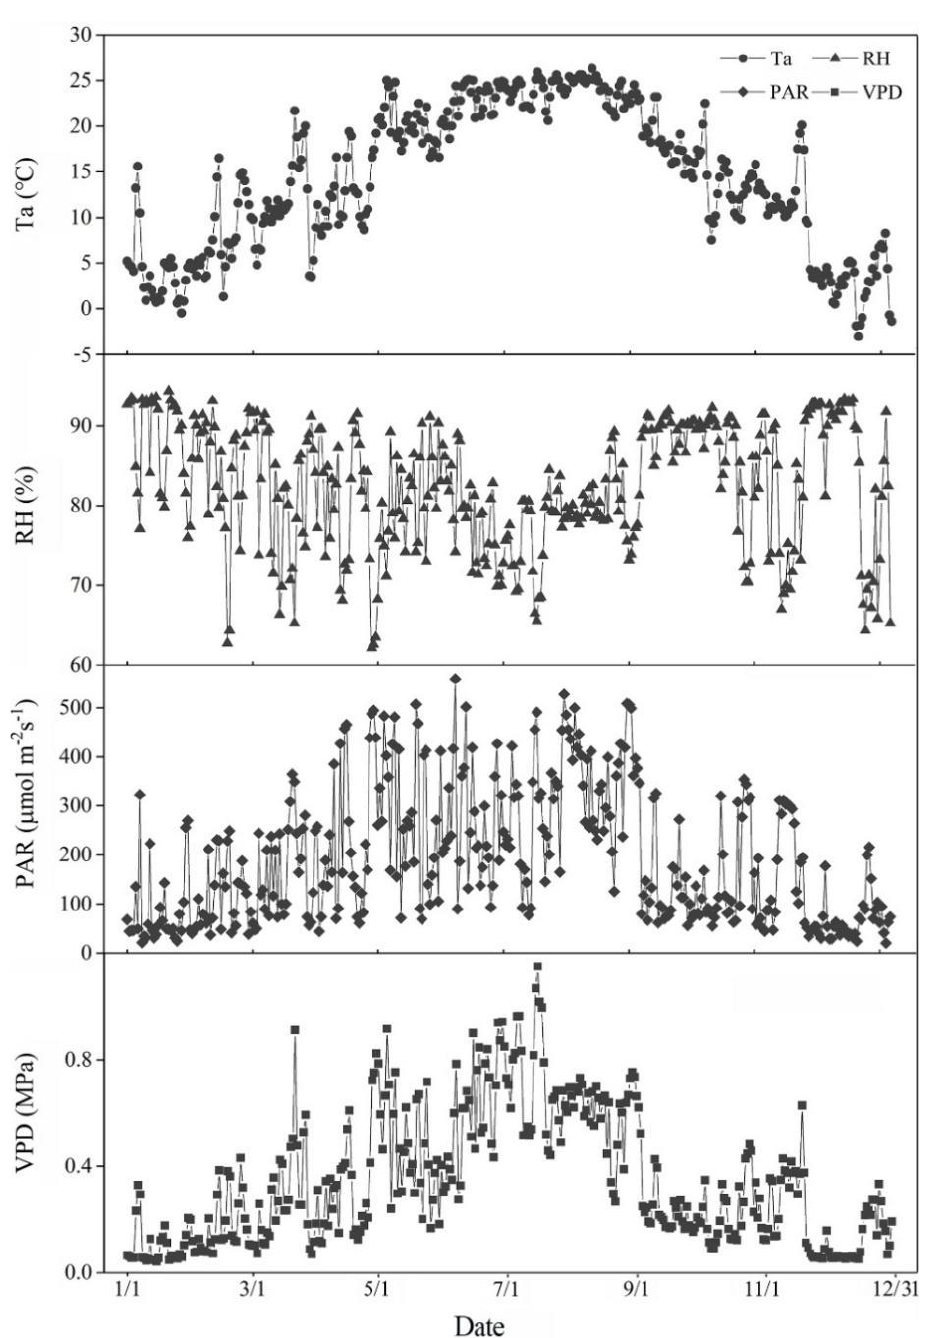
Figure 2. Monthly trends of environmental factors affecting tree sap flow activity during the 2020 study period. From top to bottom are temperature (Ta), relative humidity (RH), photosynthetically active radiation (PAR), and saturated water pressure difference (VPD). As an environmental factor affecting tree growth, it has an inseparable impact on plant sap flow activity and therefore requires monitoring.